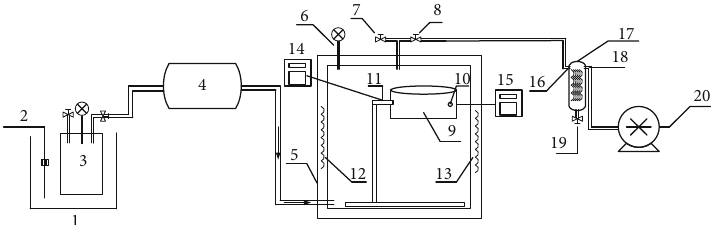
Figure 1: The enrichment and drying experiment platform. (1) Water bath, (2) water bath constant temperature heater, (3) vacuum barrel, (4) superheater, (5) drying box, (6) pressure gauge, (7) vent valve, (8) exhaust port, (9)material rack, (10) temperature sensor, (11) weight sensor, (12) aluminum foil heater, (13) aluminum foil heater, (14) weighing system, (15) temperature detection system, (16) condenser air inlet, (17) catch water, (18) condenser gas outlet, (19) drainage outlet, and (20) vacuum